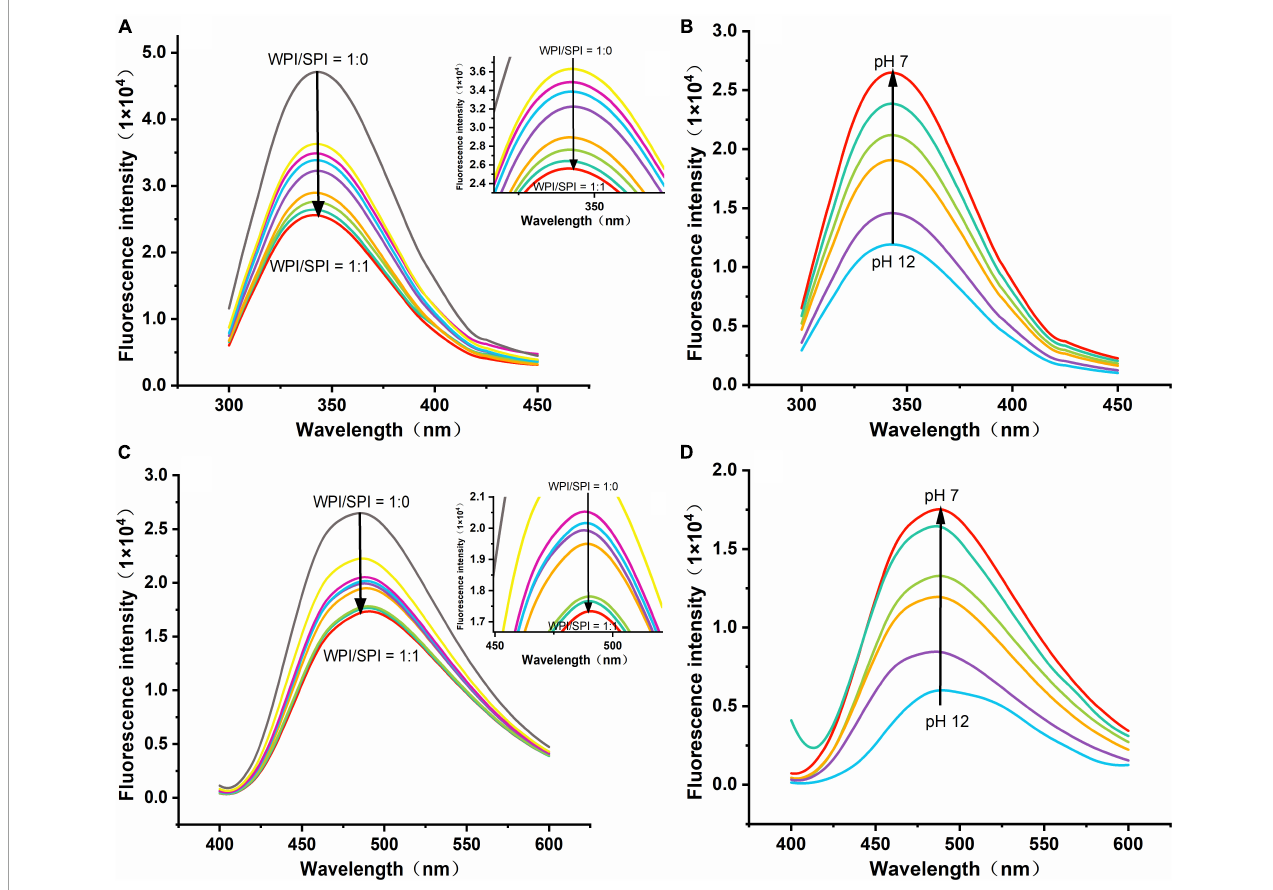
FIGURE5 (A) Emission spectra of composite nanoparticles with WPI: SPI (w/w) from 1:0 to 1:1. (B) Emission spectra of composite nanoparticles (WPI: SPI = 1:1, w/w) at pH 12, 11, 10, 9, 8, and 7. (C) Emission spectra for ANS binding to composite nanoparticles with WPI: SPI (w/w) from 1:0 to 1:1. (D) Emission spectra for ANS binding to composite nanoparticles with WPI: SPI (WPI: SPI = 1:1, w/w) at pH 12, 11, 10, 9, 8, and